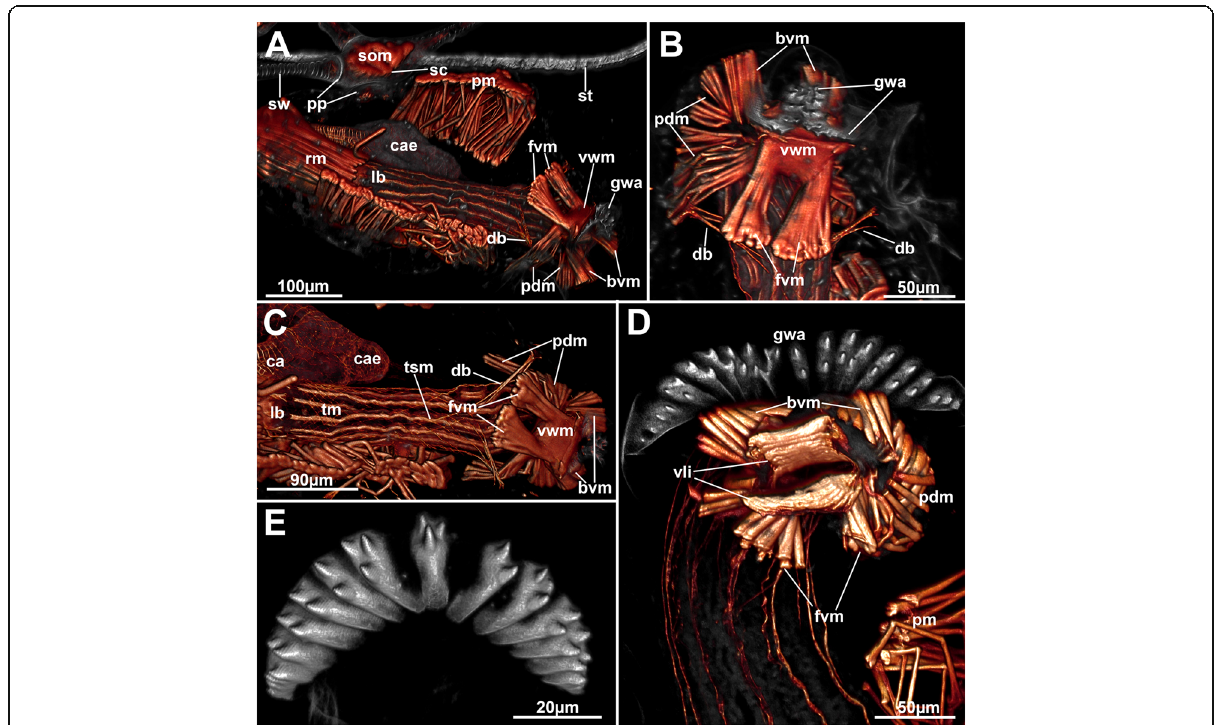
Fig. 4 Overview of the apertural area of Hyphophorella expansa . Autofluorescence in gray, f-actin in glow, CLSM. a Oblique view of a zooid attached to the stolon capsule. b View from the frontal side of the aperture with unfolded vestibular wall bearing the gnawing apparatus. The rows of teeth are medially opposed. c Frontal overview of the muscular system of an autozooid. d Close-up of the apertural area with protruded gnawing apparatus. The teeth are now aligned in a single row. e Isolated gnawing apparatus showing autofluorscent teeth rows. Abbreviations: bvm – basal vestibular muscles, ca – cardia, cae – caecum, db – duplicature bands, fvm – frontal vestibular muscles, gwa – gnawing